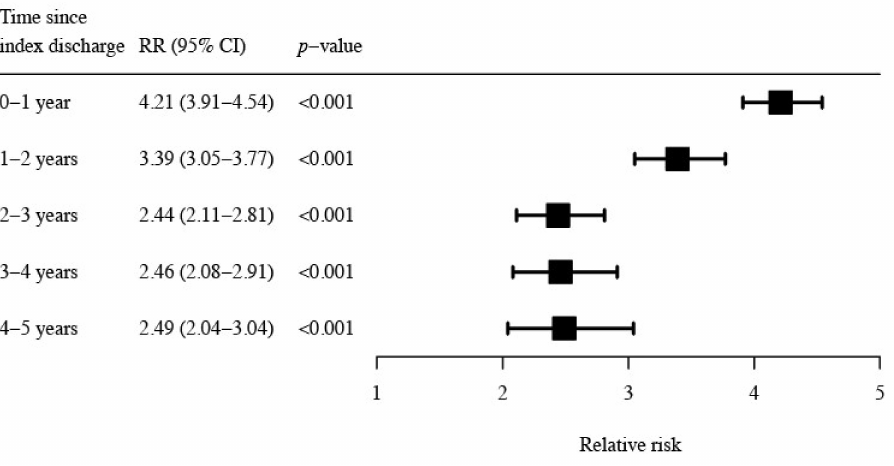
Figure 2. Relative risk of a post-index ADR-related admission for patients with ADR compared to non-ADR-related index admissions. Bars represent 95% confidence